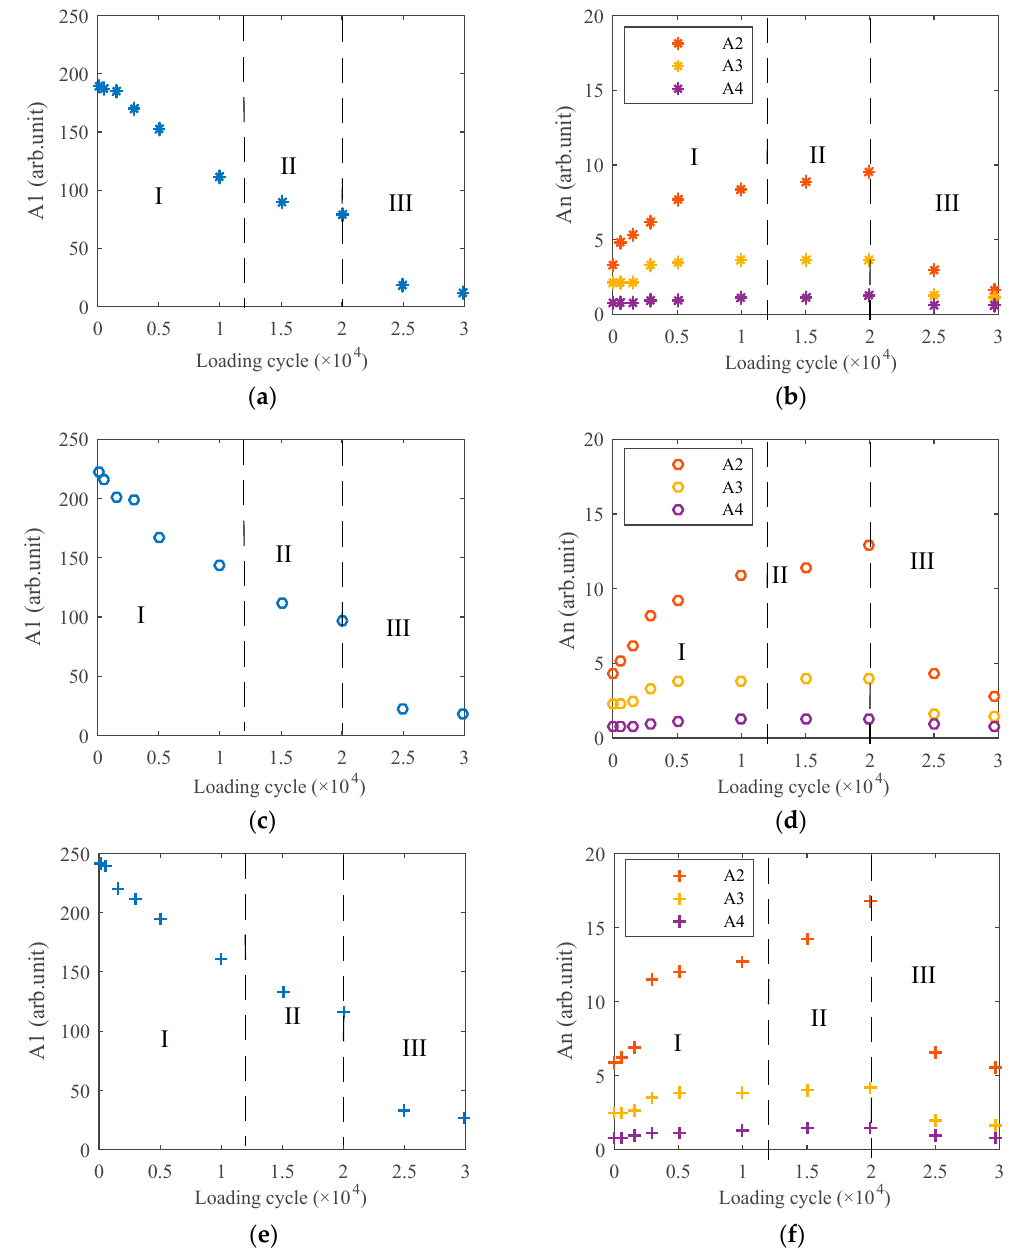
( b ) Figure 10. ( a ) Transmitted signals received from the fatigue sample (Loading Cycle 29800) in the time- domain and ( b ) in the frequency-domain (excitation voltage 200 V).